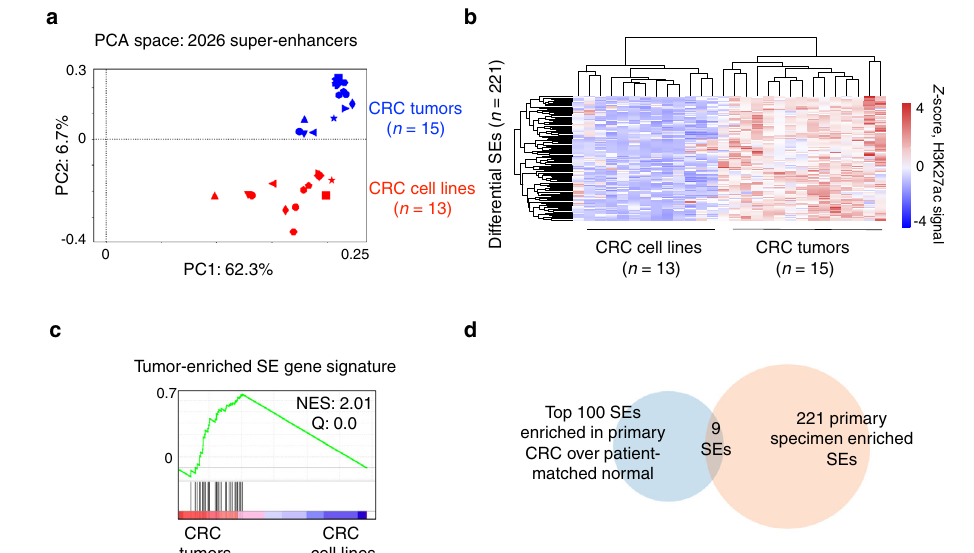
Fig. 2 | A subset of super-enhancers is speci fi c to primary CRC specimens and not recapitulated in CRC cell lines. a PCA of H3K27ac signal at 2026 SEs in CRC ( n =15 independent tissue samples) and CRC cell lines ( n =13 independent cell lines). Please see Methods for accessions. b Heatmap of H3K27ac signal ( Z- score) between CRC tumors and CRC cell lines with unsupervised hierarchical clustering andPearson ’ scorrelationtesting.221SEs(outof 2026)down-regulatedinCRC cell lines compared to primary tumors (mean H3K27ac signal log 2 fold change< − 1,